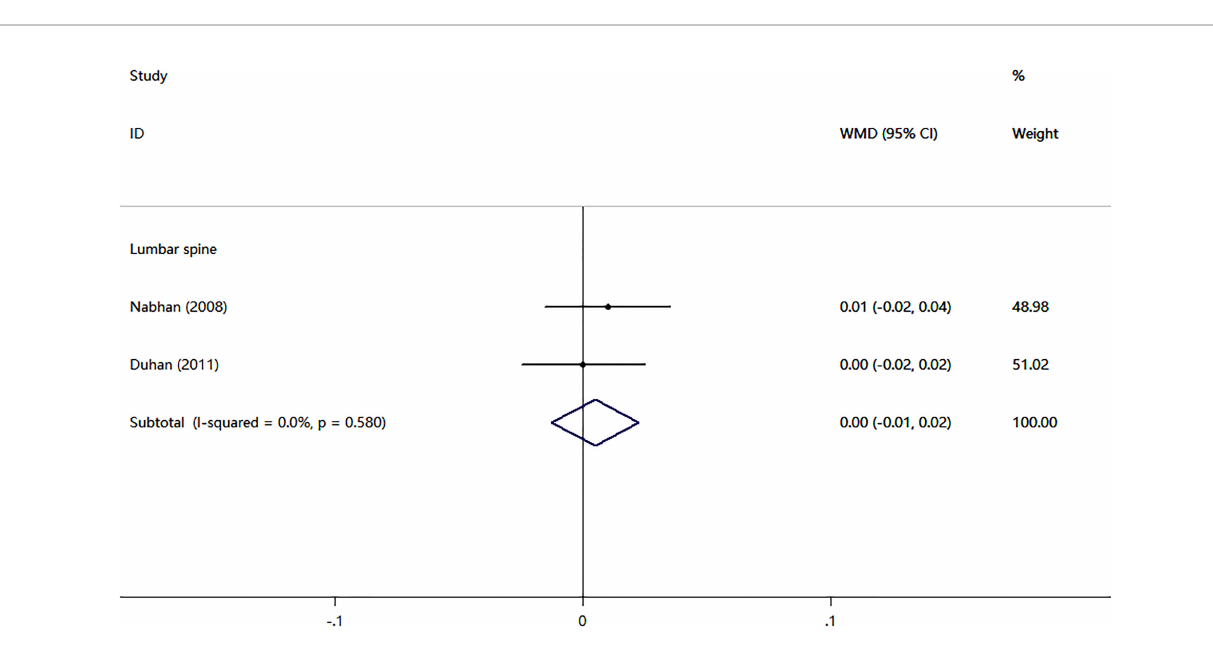
Frontiers in Endocrinology |